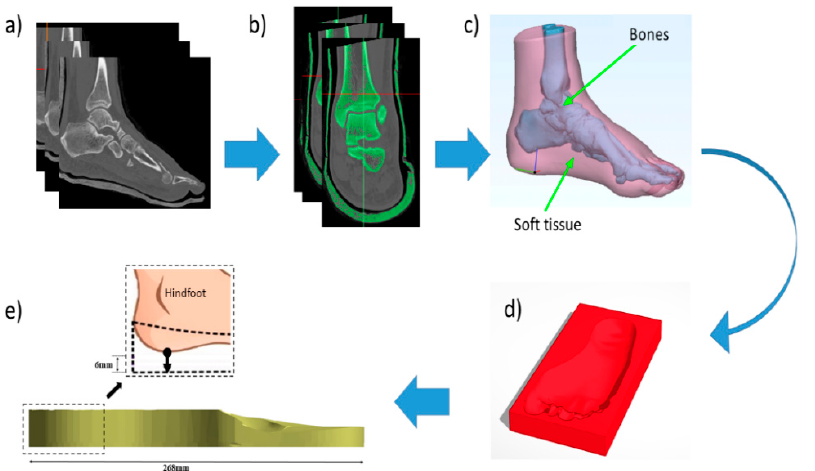
Figure 1. Finite element model generation through various steps including ( a ) the computerized tomography (CT) scan images of foot, ( b ) processed CT images with segmentation, ( c ) recon- structed foot model with bones and soft tissue, ( d ) subtracted foot from box to construct a custom- made insole (CMI) and ( e ) CMI dimensions following the foot morphology and